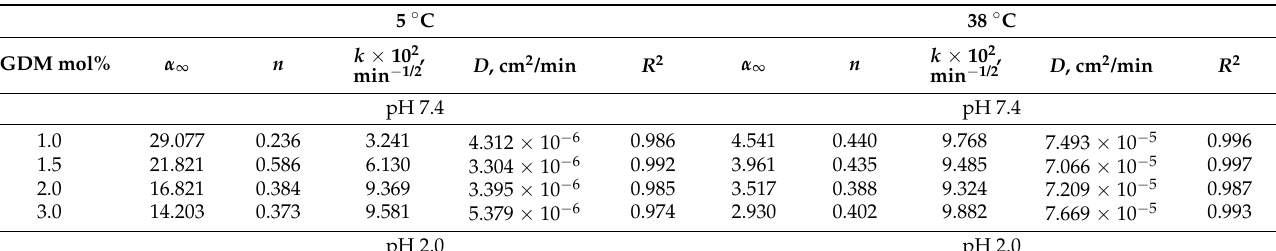
Table 2. Equilibrium Swelling Ratio ( α ∞ ) and Kinetic Parameters ( n , k and D ) at 5 ◦ C and 38 ◦ C in Fluids at pH 7.4 and 2.0 for p( N iPAm- co -HPMet) Hydrogels with Different EGDM